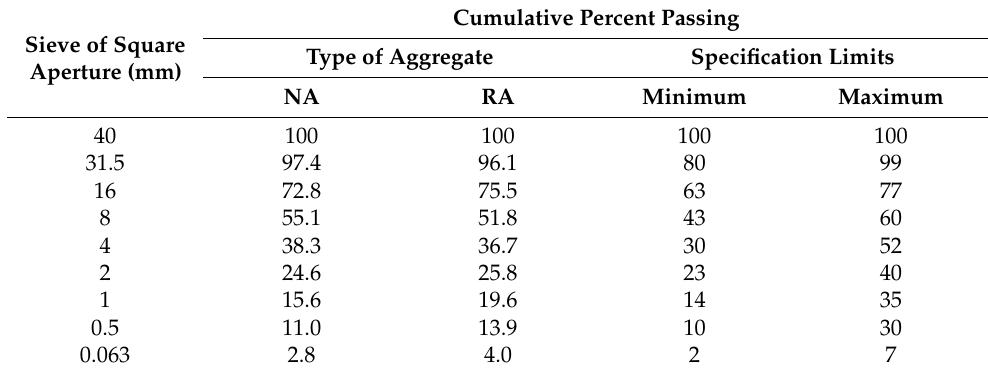
Table 2. Aggregate particle size distribution and specification limits used as